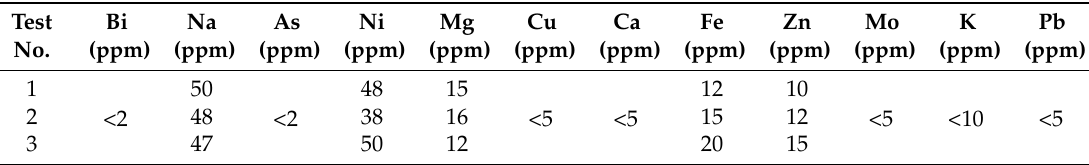
Table 9. Impurity contents after purification.